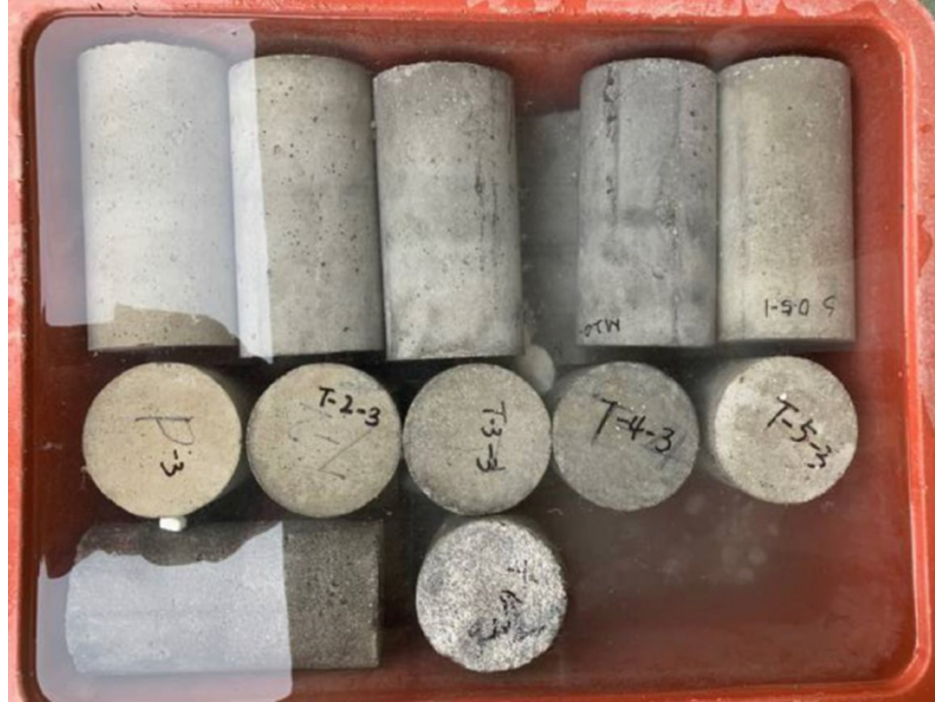
Figure 2. Immersion in sulfuric acid solution.